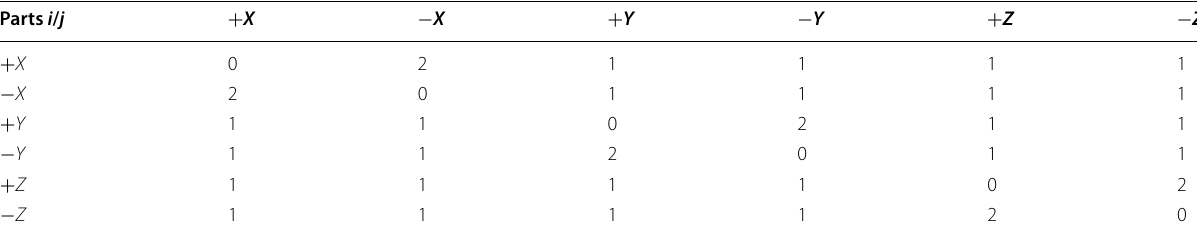
Table 2 The information on the penalty cost of disassembly direction changing